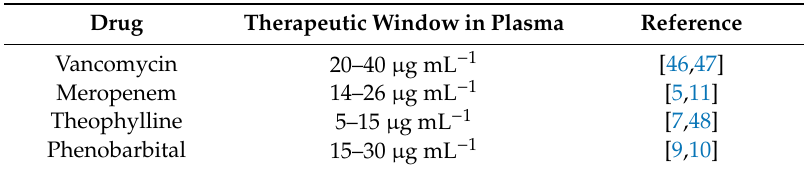
Table 2. Therapeutic range of various drugs.